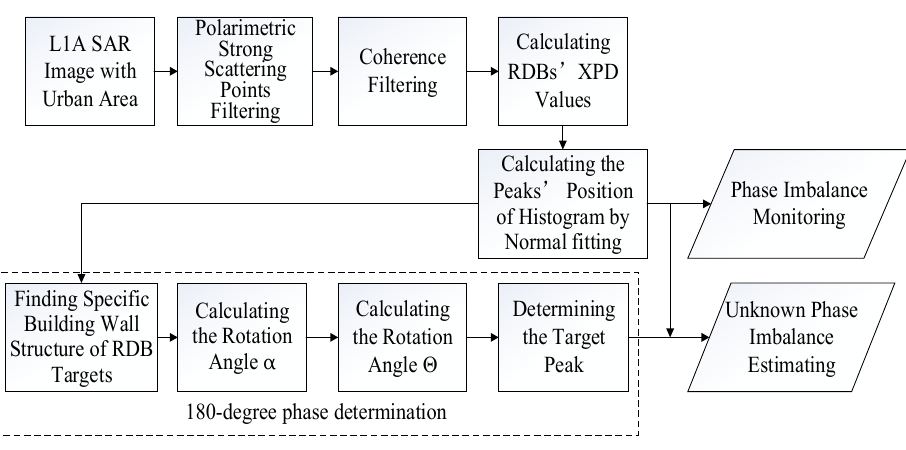
Figure 3. The flowchart of the phase imbalance estimation algorithm.